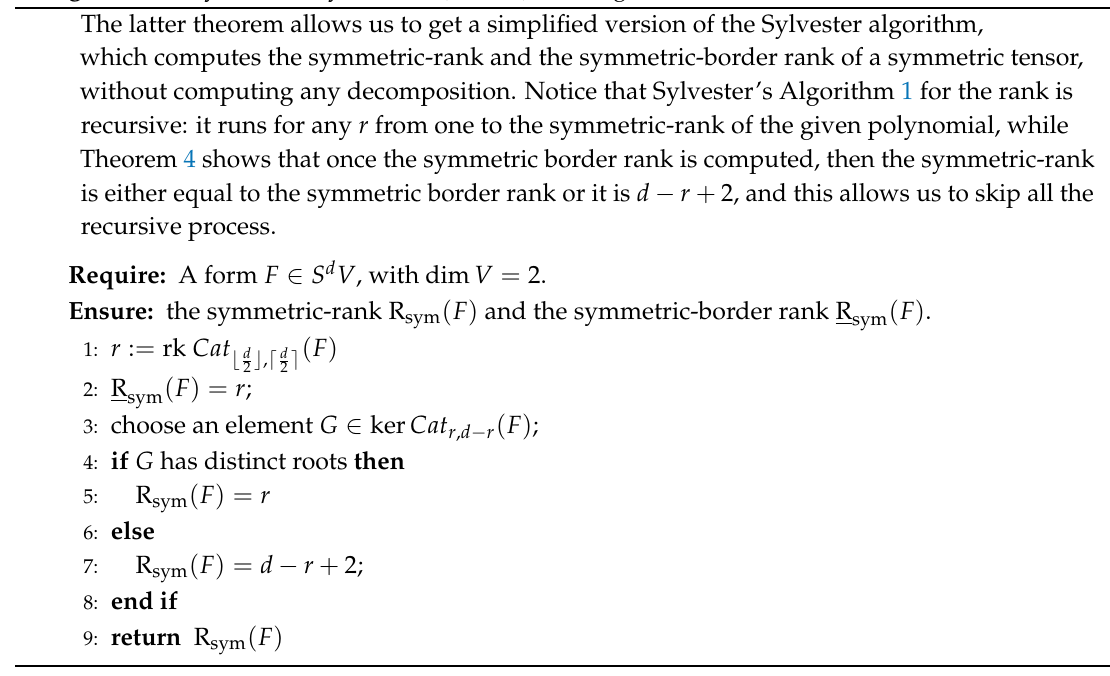
Algorithm 2: Sylvester’s symmetric (border) rank algorithm